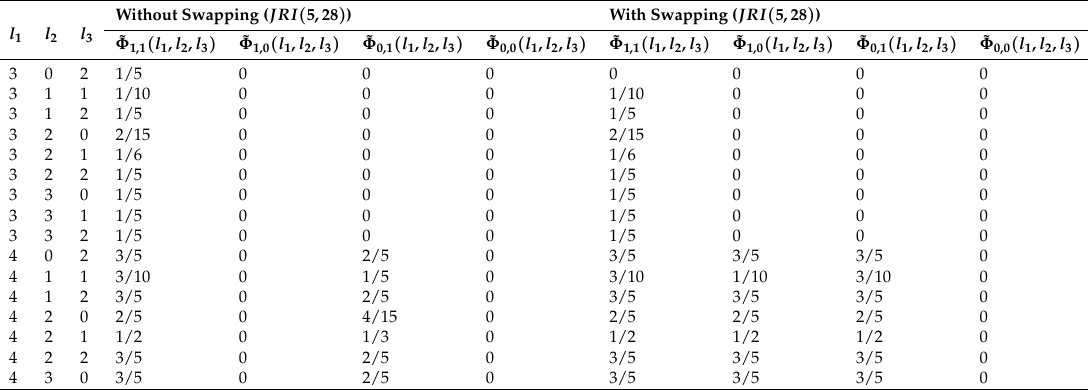
Table A4. Survival signatures of given states of components 5 and 28 (rows with ˜ Φ i , j = 0 are omitted). Without Swapping ( JRI ( 5,28 )